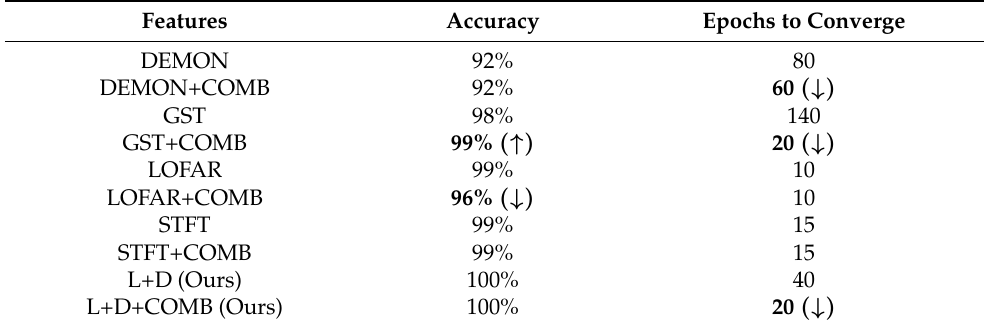
Table 6. Prediction accuracy and convergence speed of each feature when comb filtering is included or not, based on features before and after enhancement, L+D is the abbr. of LOFAR+DEMON. Changes in accuracy and convergence speed are highlighted in bold format.